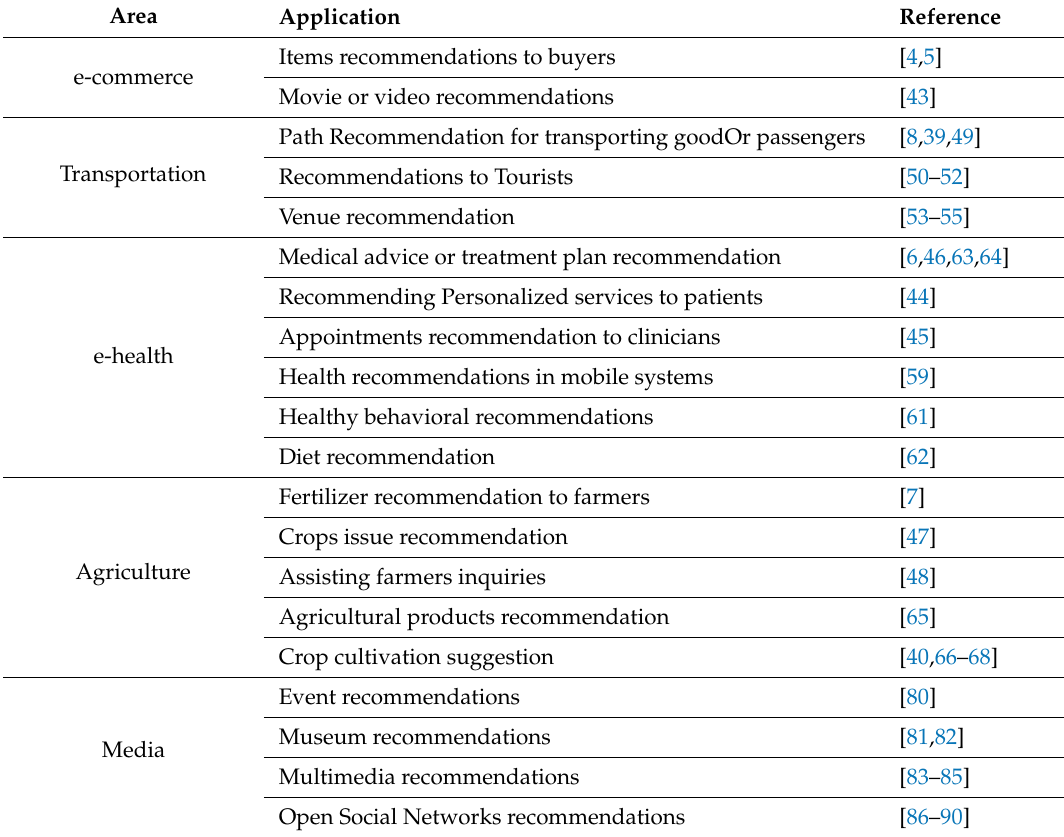
Table 2. Business adoption of Recommendation Systems (RSs) in five application